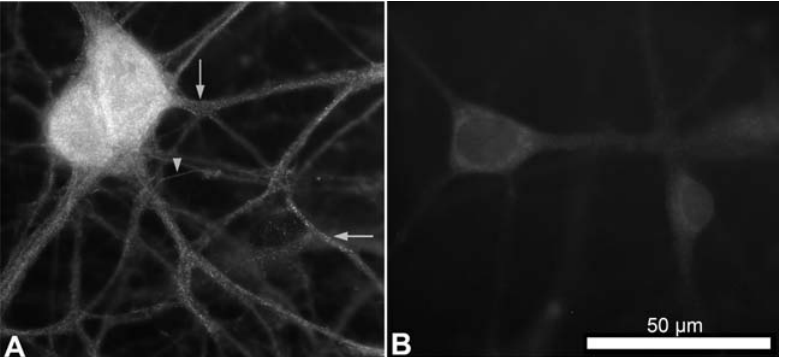
Figure 7. Expression of FMN2 protein in hippocampal neurons. (A) Neurons exhibited pronounced fine granular immunoreactivity for FMN2. The cell body had the strongest signal. The fine granular staining extended into apical and distal dendrites (arrows). Thin axon-like processes were also labeled (arrow head). (B) The fine granular staining is not detected in controls of sister cultures processed in parallel without the first antibody.